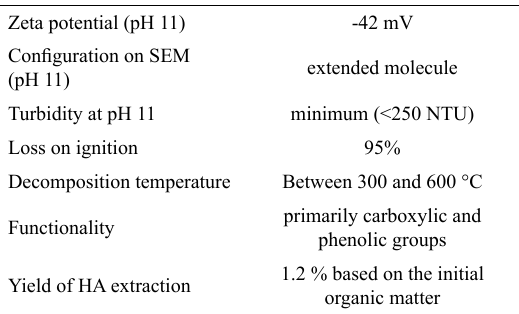
Table 1. Properties of humic acid